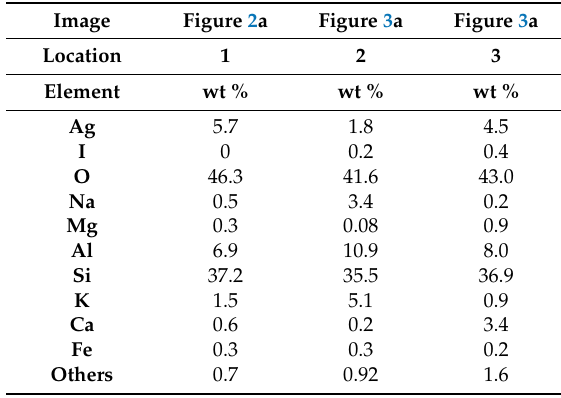
Figure 4. Microstructure of the AgZ 1-8 sample shown by by: ( a ) SEM micrograph; and the corresponding EDS maps of: ( b ) Ag; ( c ) I; ( d ) Al; ( e ) K; and ( f ) Si. The large white inclusion in ( a ) is Fe (source not known) with AgI particles within the structure. The SFA samples were also comprised of a multiphase microstructure. The SPS-1 sample can be seen in the SEM micrograph in Figure 5a and large features were observed in the image. The Ag was